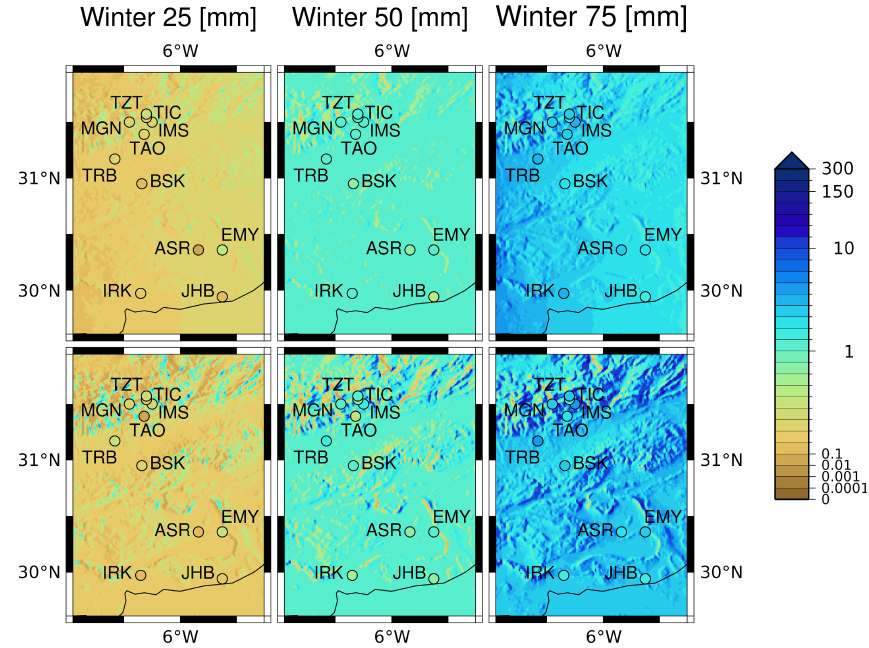
Fig. 7. Transformation of distribution and multiple linear regression applied to observations and topographic data. From left to right: 25th, 50th and 75th quantile. Top (bottom): basic distribution is estimated from all winter values with an even (odd) entry number. The points at the test sites are coloured according to the calculated quantiles.